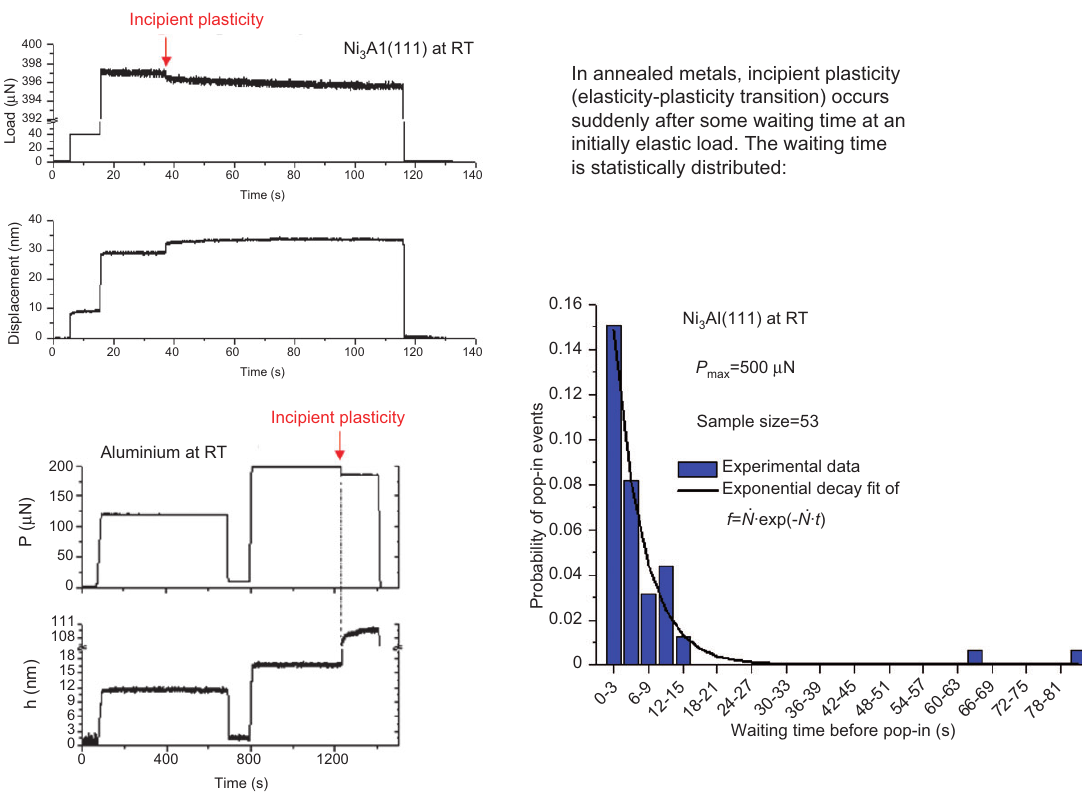
Figure 2 Delayed incipient plasticity observed during nanoindentation of well-annealed Ni